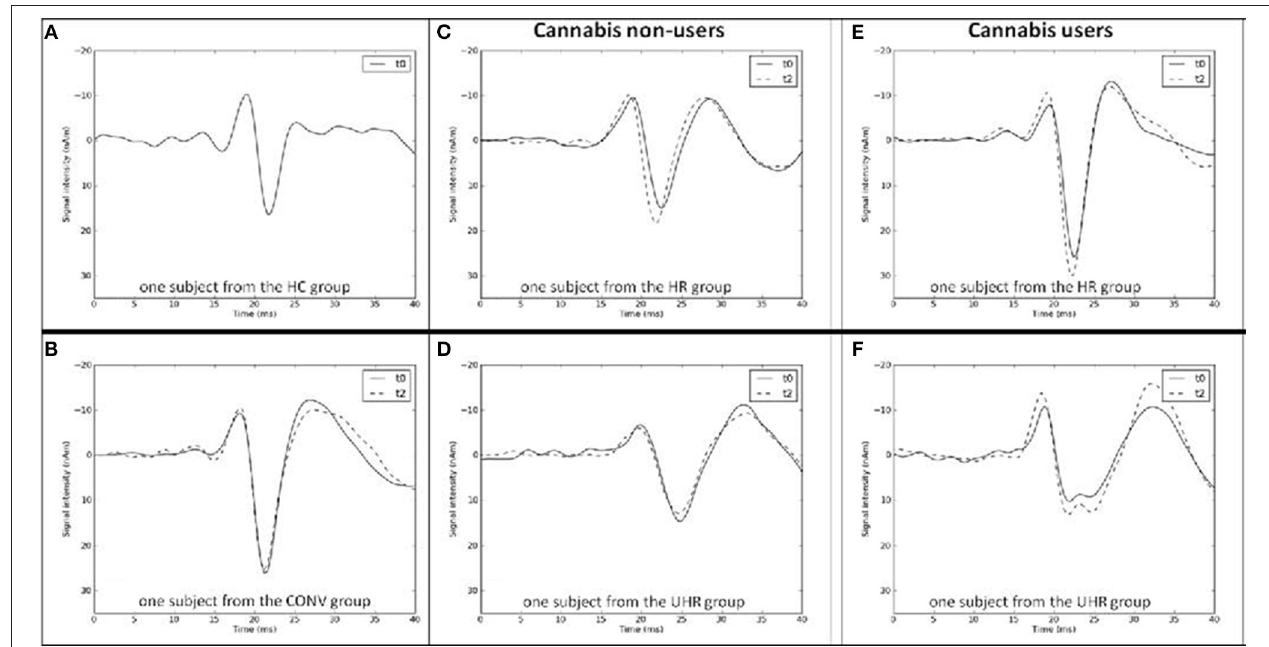
FIGURE 1 | Examples of N20 curves at baseline (t0) and at follow-up (t2) from the (A) healthy control (HC), (B) converter (CONV), (C) high-risk (HR) cannabis non-users, (D) ultra-high-risk (UHR) cannabis non-users, (E) high-risk (HR) cannabis users, and (F) ultra-high-risk (UHR) cannabis users